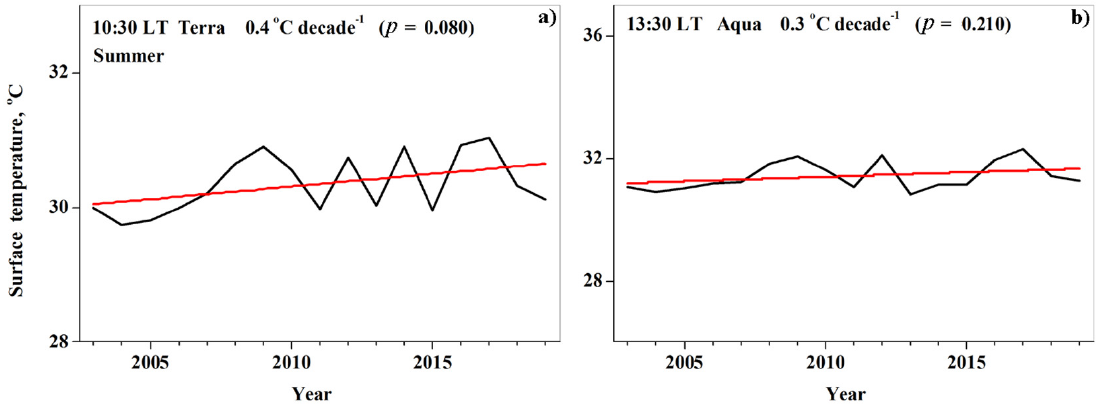
Figure 11. Year-to-year variations of Kinneret surface water temperature in summer based on ( a ) MODIS/Terra data at 10:30 LT and on ( b ) MODIS/Aqua data at 13:30 LT. The straight red lines designate linear fits.